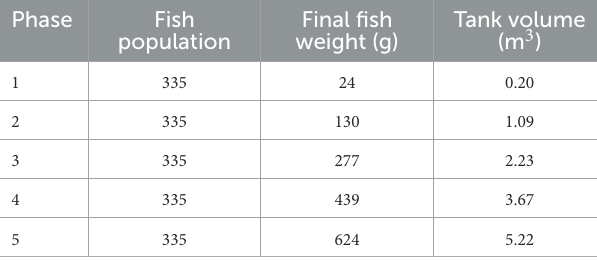
TABLE 4 Tank volume based on final fish weight and stocking